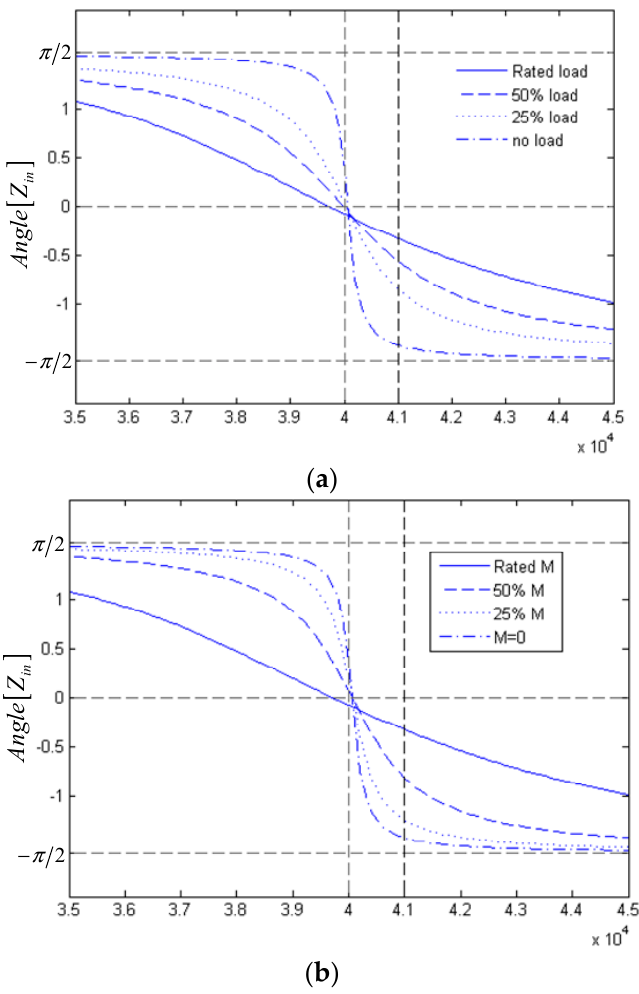
Figure 14. Relationship between Angle [ Z in ] and operating frequency of the experimental system: ( a ) R L varies, M = 11.53 μ H; ( b ) M varies, R L = 10 Ω .